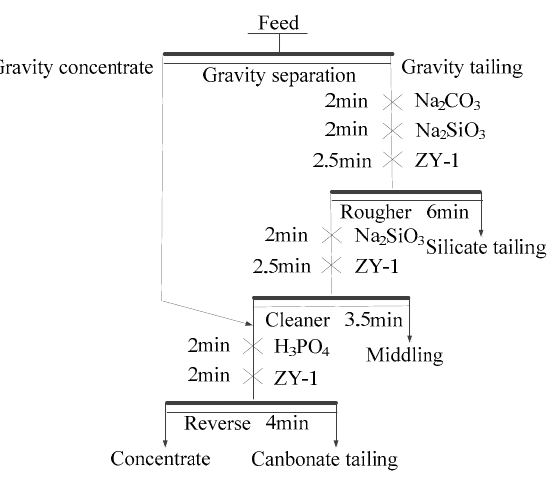
Figure 5. Conventional gravity-flotation combination process.